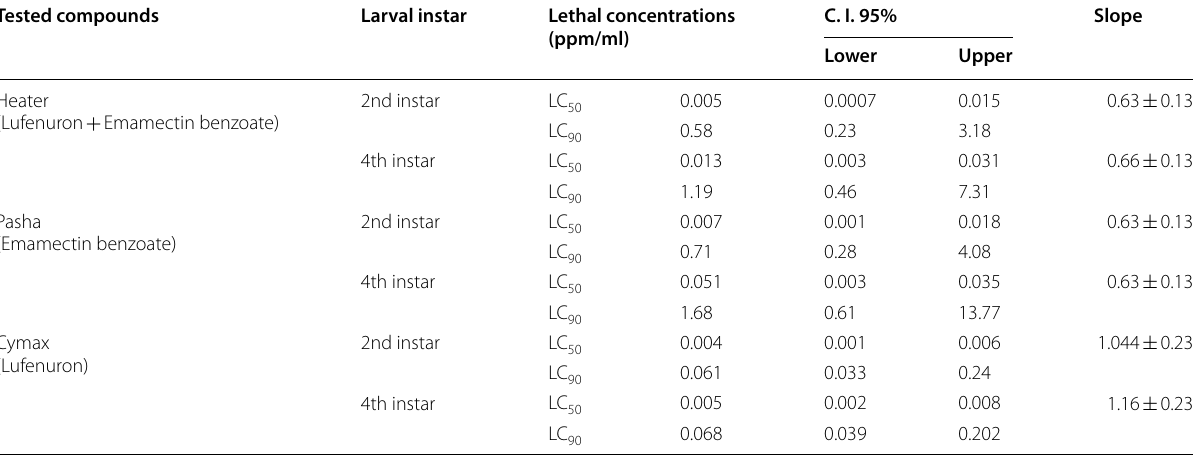
Table 4 Susceptibility of S. littoralis to the tested compounds Tested compounds